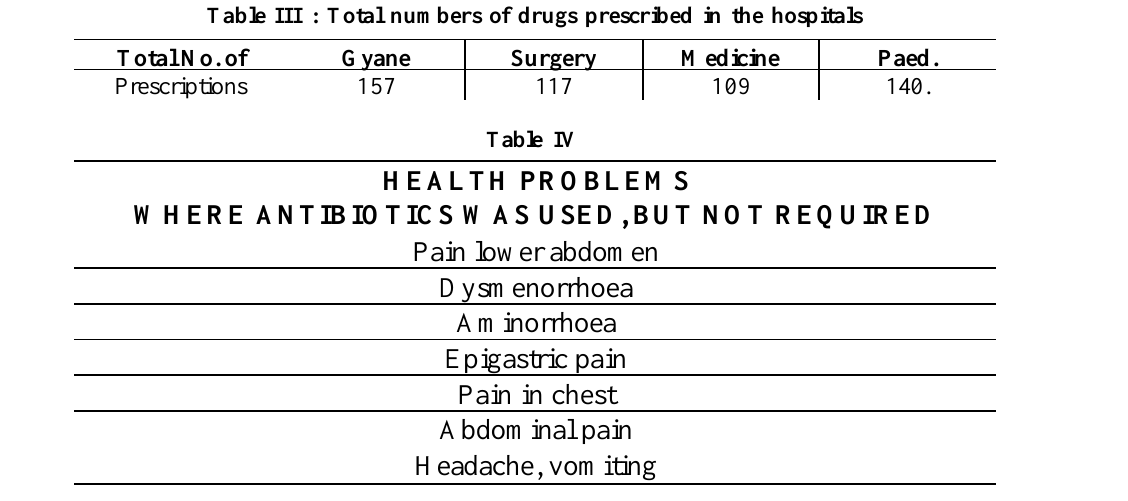
Table V : Showing percentage of antibiotic prescribed after investigations done in only 24.5% of cases